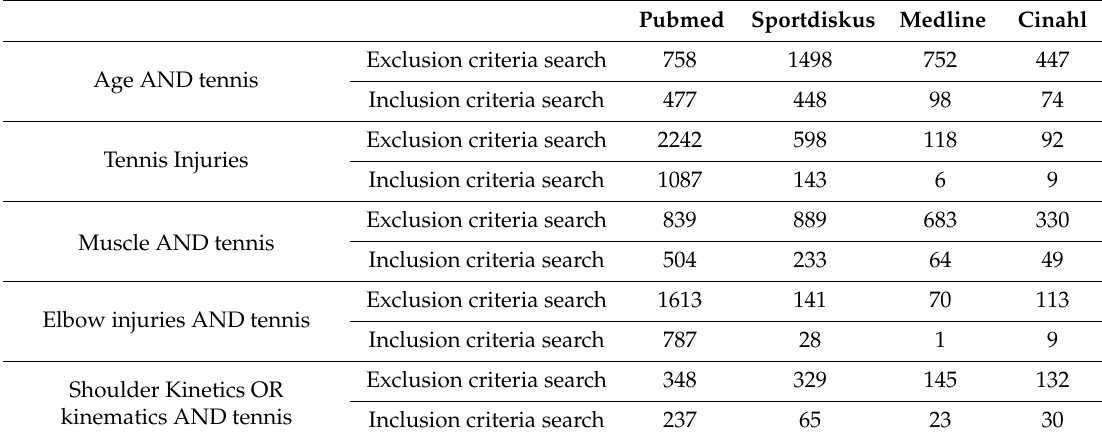
Table 1. Overview of the database